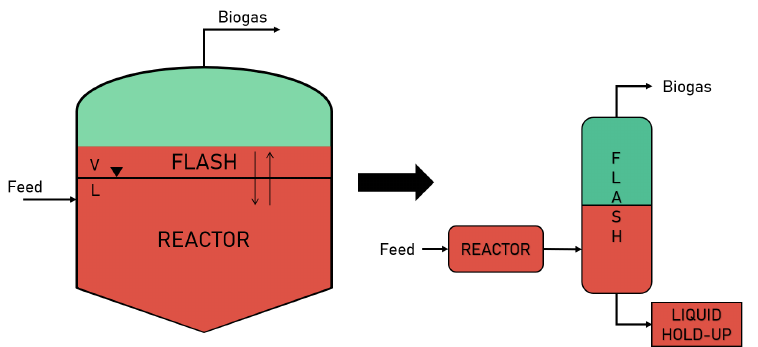
Figure 1. Schematisation of the anaerobic digestion into a flash unit for thermodynamic